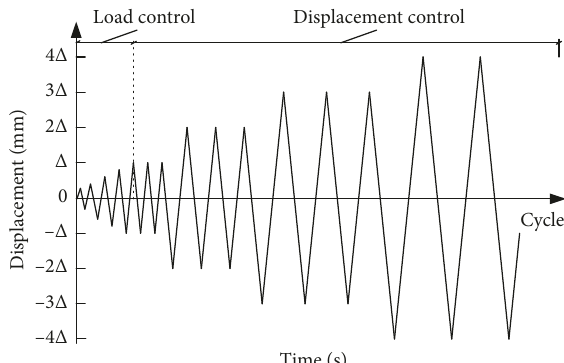
Figure 3: Loading protocols of the